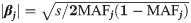
The statistical power of regional association analysis with weighted FLM on the familial data with effect modeled as |βj|=s/2MAFj(1-MAFj) and all causal variants having MAFs ≤ 0.03.Other model parameters and the notations are the same as in Fig 2.